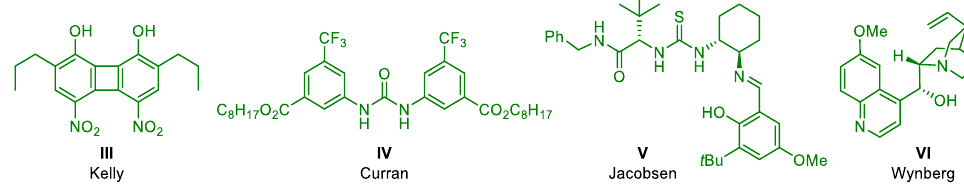
Figure 1. Crucial organocatalytic structures reported previously to